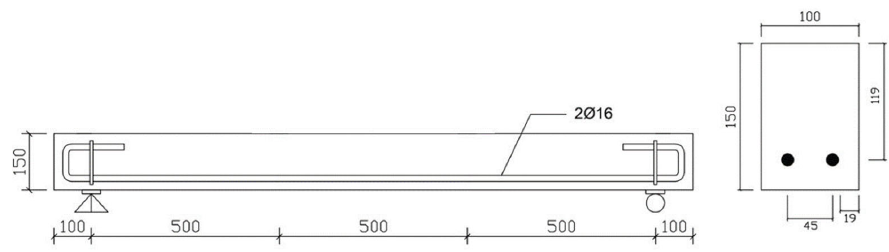
Figure 2. Reinforcement arrangement.